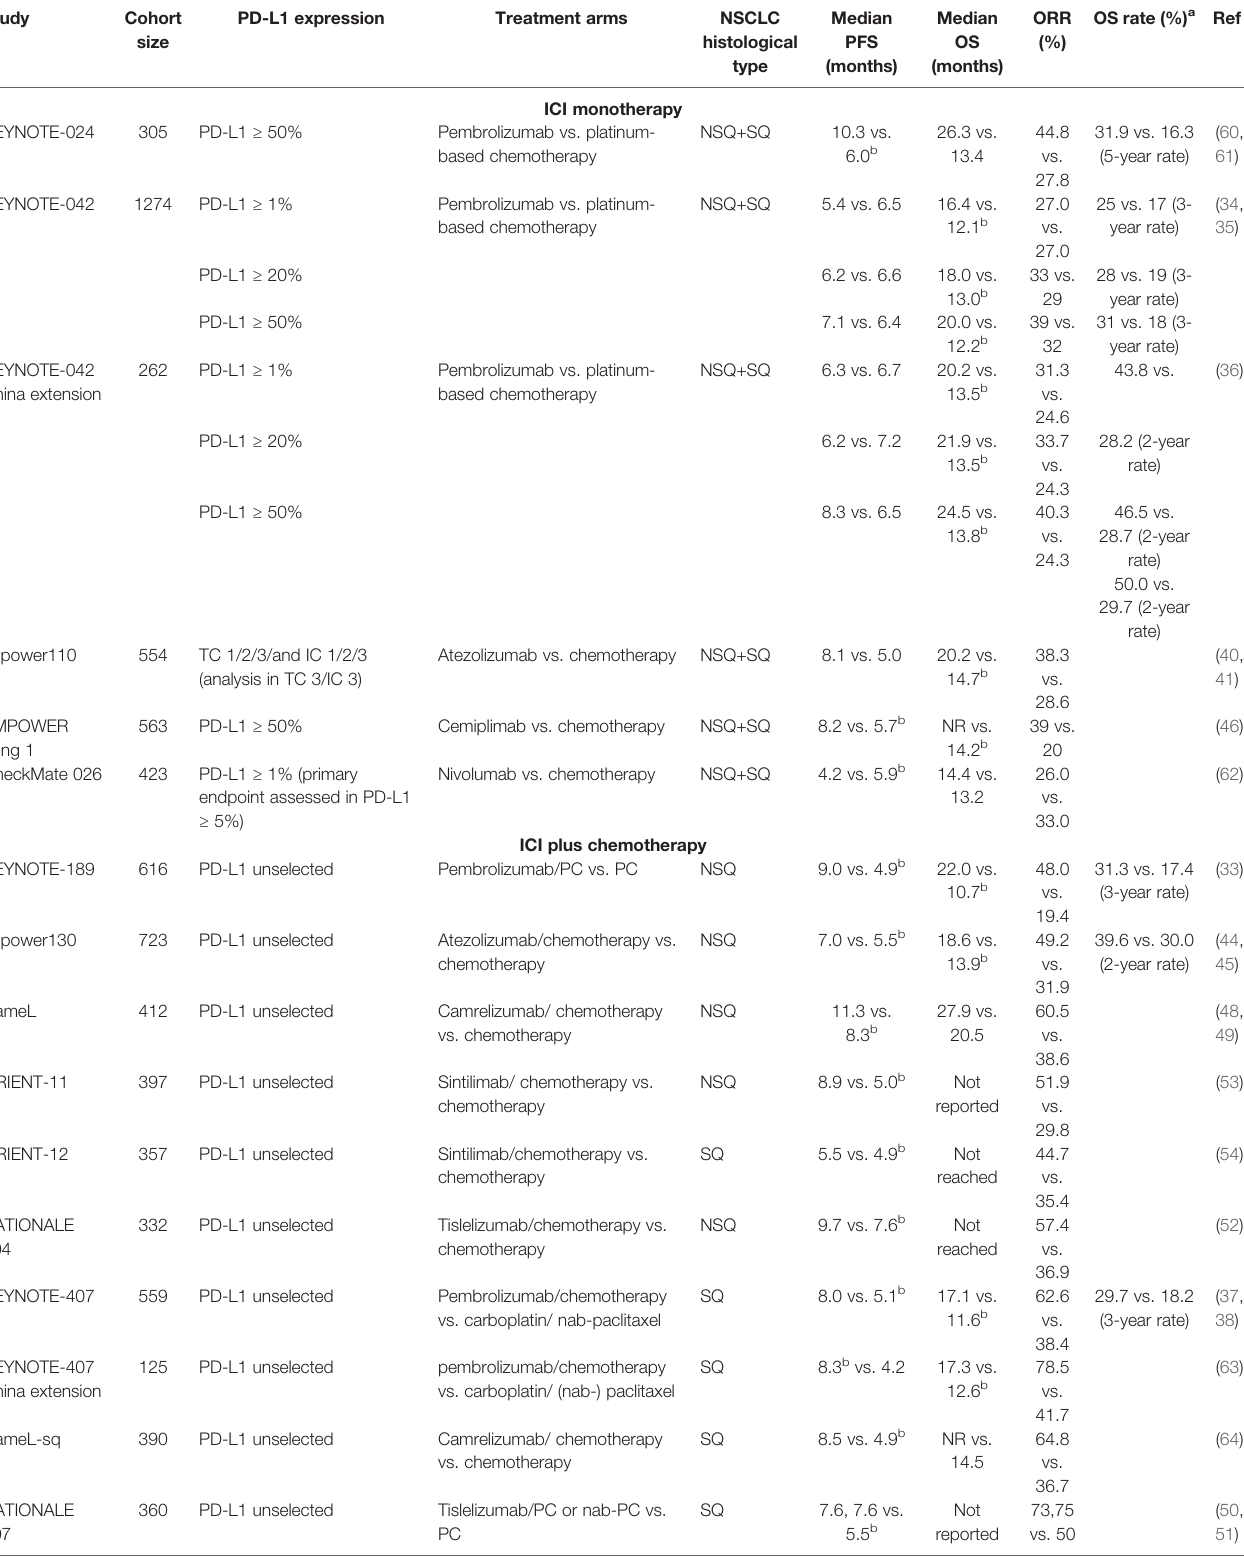
TABLE 2 | Summary of key phase III trials using immune checkpoint inhibitors as fi rst-line monotherapy or combination therapy for